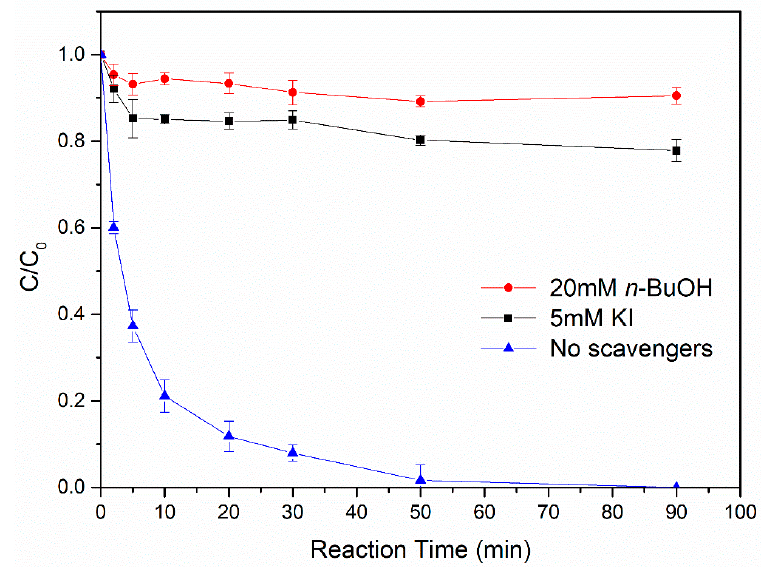
Figure 9. Effect of radical scavengers on the degradation of 2,4-D in the Fe 0 @Fe 3 O 4 /H 2 O 2 system Figure 9. E ff ect of radical scavengers on the degradation of 2,4-D in the Fe 0 @Fe 3 O 4 / H 2 O 2 system ([2,4-D] 0 = 5.0 mg/L, [Fe 0 @Fe 3 O 4 ] 0 = 0.5 g/L, H 2 O 2 = 1 mM, pH = 5.0 ± 0.2, T = 30 °C). ([2,4-D] 0 = 5.0 mg / L, [Fe 0 @Fe 3 O 4 ] 0 = 0.5 g / L, H 2 O 2 = 1 mM, pH = 5.0 ± 0.2, T = 30 ◦